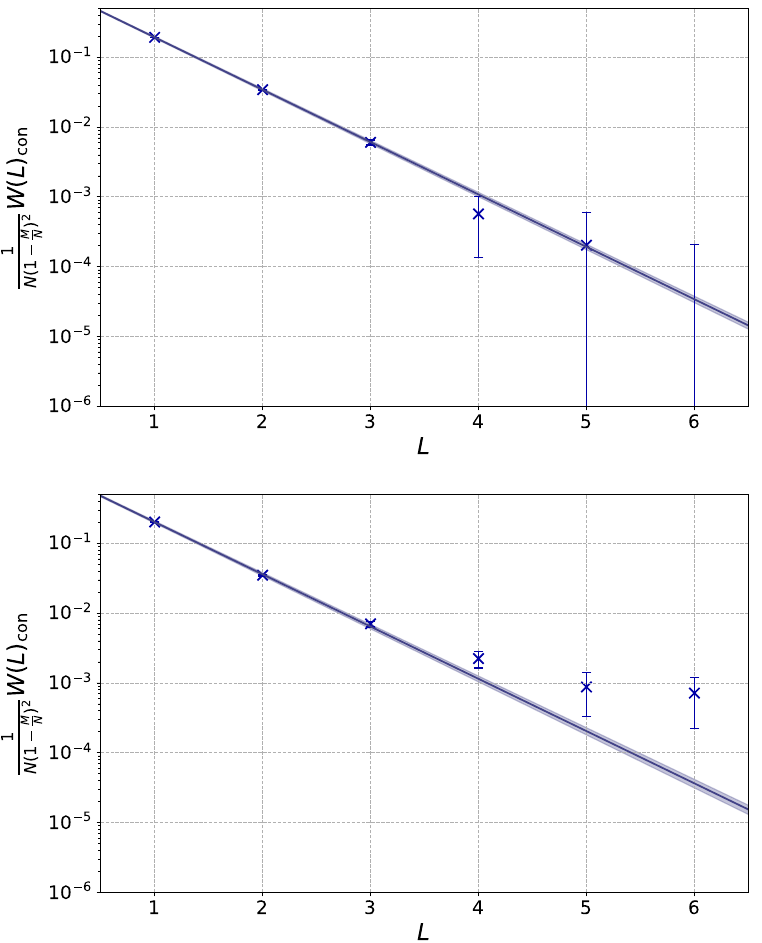
W con ( L ) = γ con ( L ) + N (1 − M ) 2 N